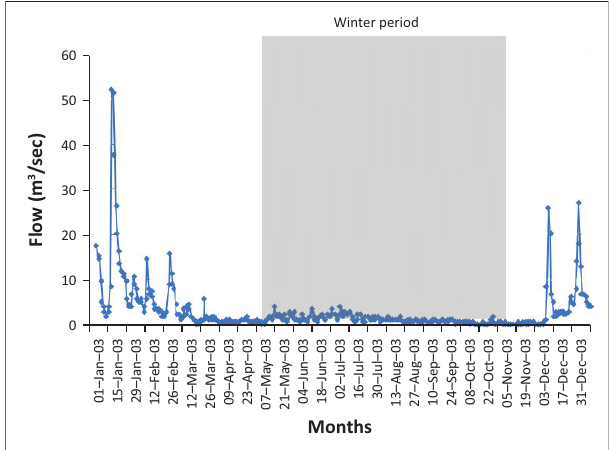
FIGURE 4: Water flow in the Incomati River over the period January–December